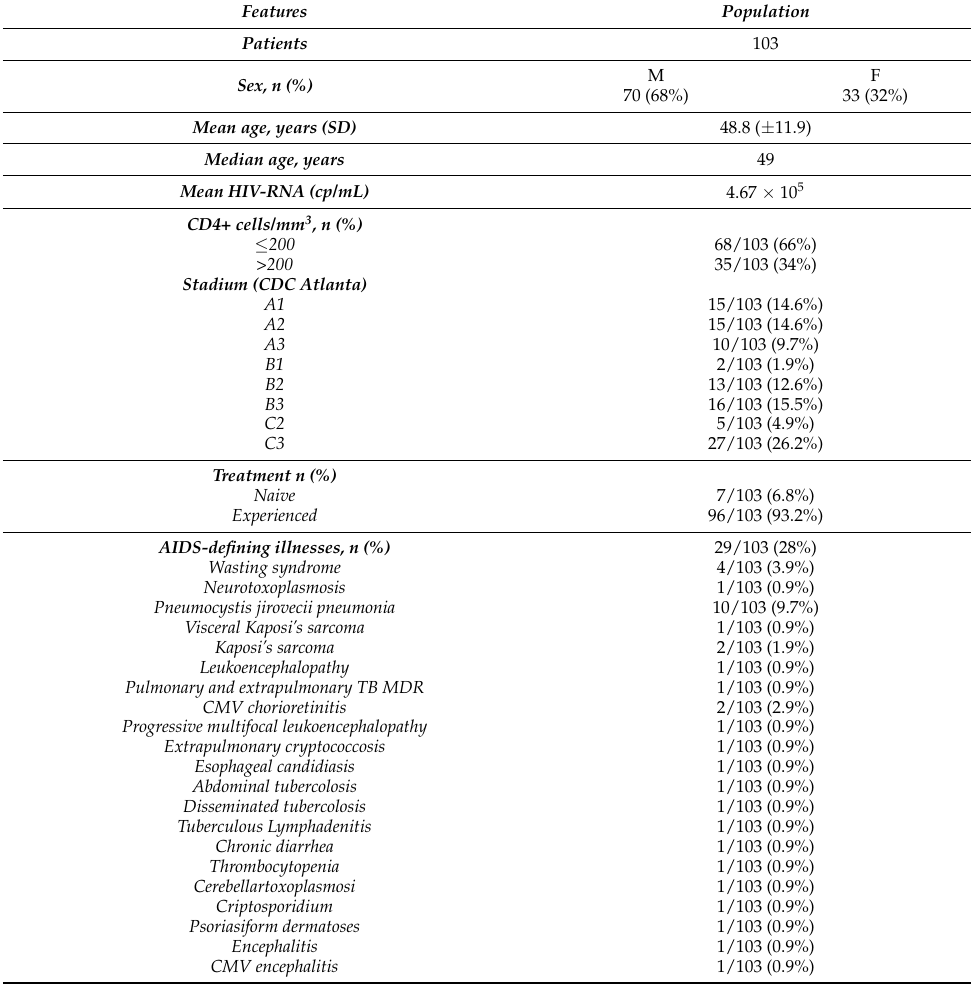
Table 1. Demographic and clinical characteristic of HIV-infected